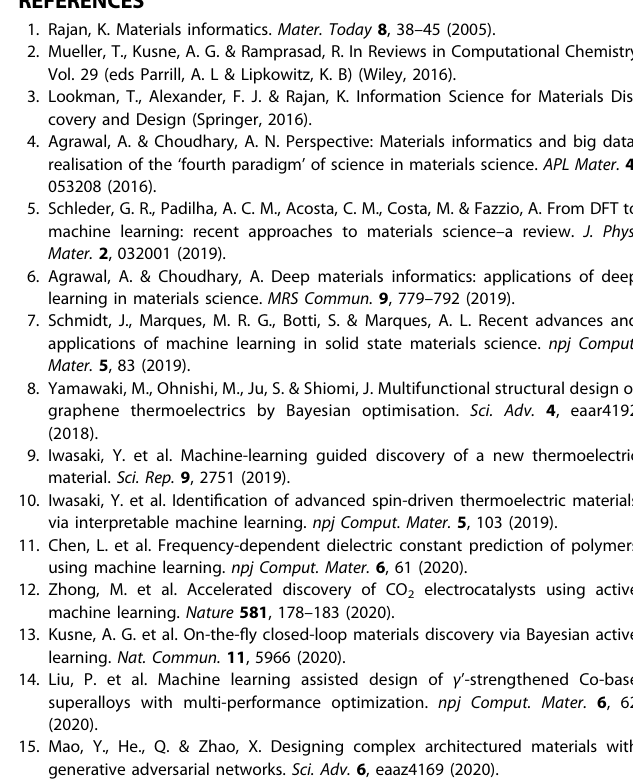
Fig. 6 Time costs at stopping timings for various XAS spectral measurements. Comparison of time costs for the spectral measure- ment with AL at automated stopping timing with several thresholds and the conventional DoE for a simulated L 2,3 XAS spectra of Ni 2 + , Mn 2 + and Co 2 + and b experimental L 2,3 XAS spectra of Ni, MnO 2 , and Co. The ratio between time to measure single spectral intensity t meas and time to change unit energy t ene is set to t meas / t ene =